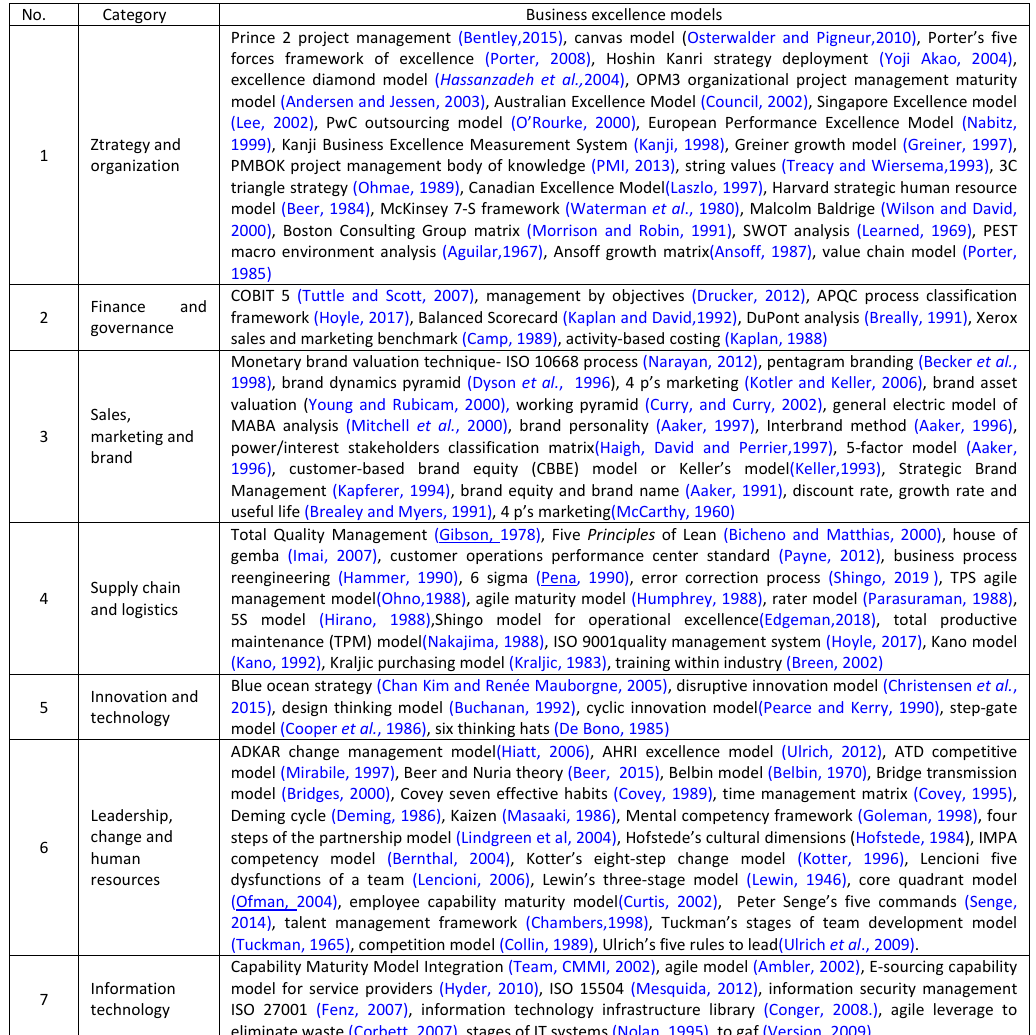
Table 1: Categorization of Finding Meta Synthesis